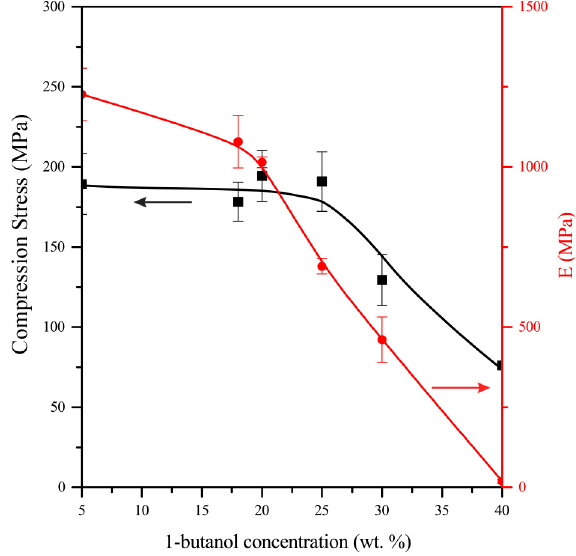
Figure 13. Dependence of the compressive elastic modulus (E C ) and compressive breaking strength ( σ B ) of polyOCM-2 samples on the concentration of 1-butanol.